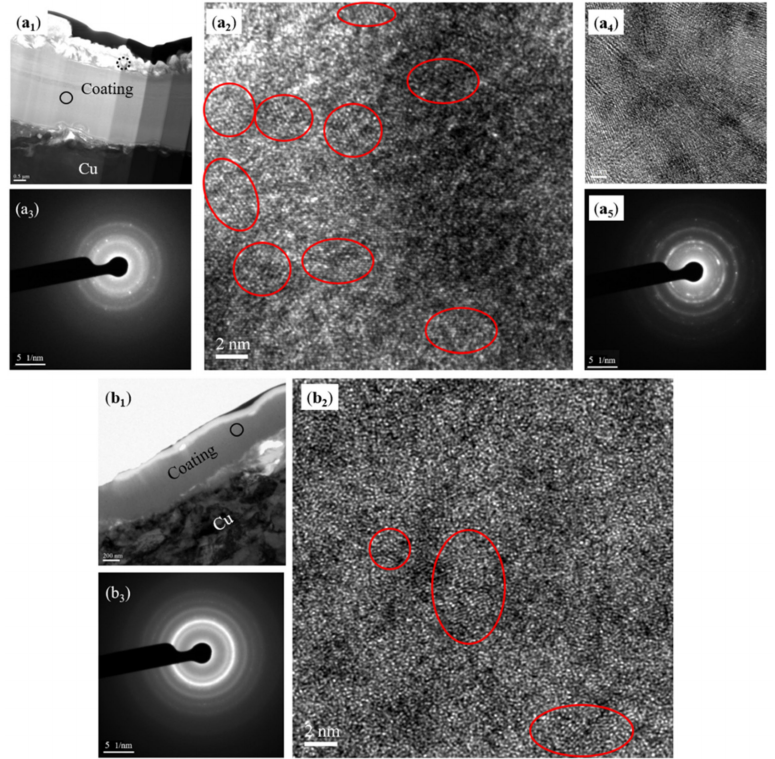
Figure 6. Bright-field images at low- ( a 1 , b 1 ) and high-magnification ( a 2 , a 4 , b 2 ), and selected area electron diffraction (SAED) patterns ( a 3 , a 5 , b 3 ) from the solid circles ( a 1 , b 1 ) and dot circle ( a 1 ). ( a 1 – a 5 ): Coating A obtained at − 2.5 V (vs. SSE) for 0.6 ks; ( b 1 – b 3 ) : Coating B obtained at − 2.5 V (vs. SSE) for 0.6 ks; ( a 2 ): observed from the inner layer ( a 1 ); ( a 4 ): observed from the out layer ( a 1 ); ( a 3 ): SAED from the solid circle in ( a 1 ); ( a 5 ): SAED from the dot circle in ( a 1 ); ( b 3 ): SAED from the solid circle in ( b 1